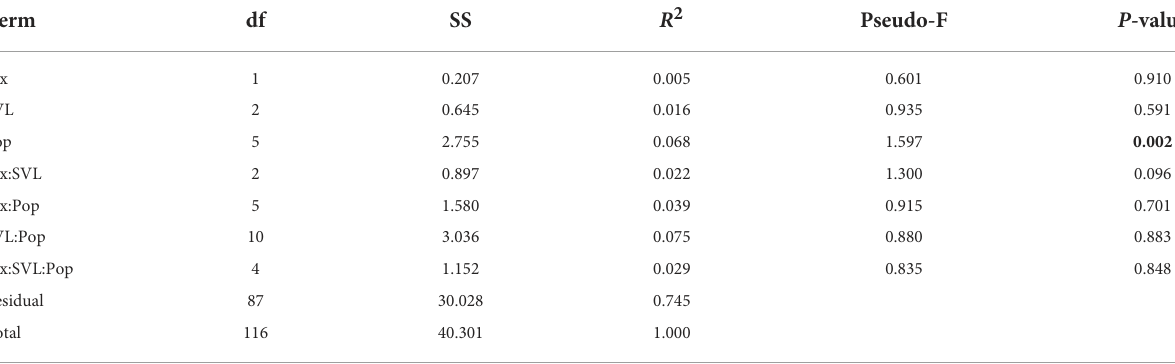
TABLE 1 PERMANOVA results of the effects of sex, population, and snout-vent length (SVL) on the diet composition of Tarentola mauritanica . Term df SS R 2 Pseudo-F P